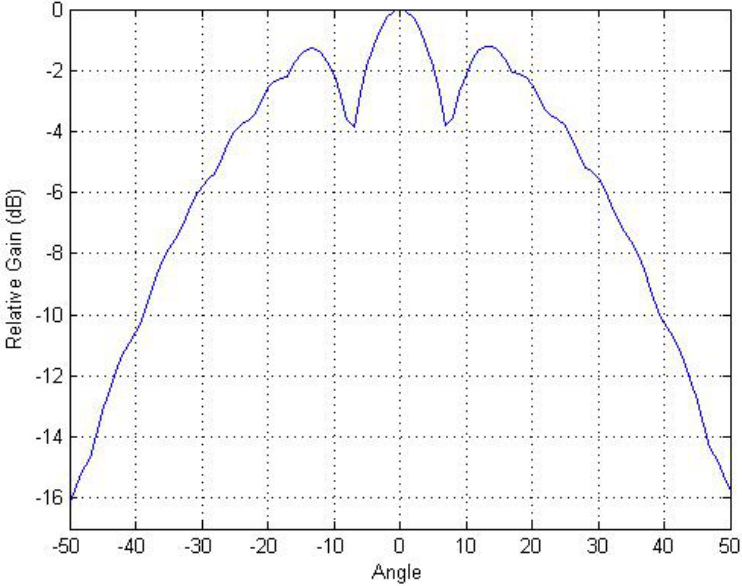
Figure 4. Experiment 1 beamforming relative gain envelope to boresight (no threshold